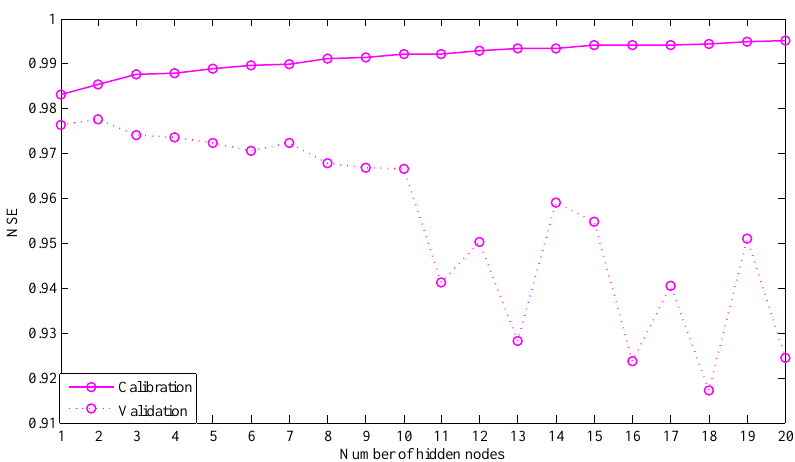
Figure 5. Correlation of each subbasin runoff and total runoff.